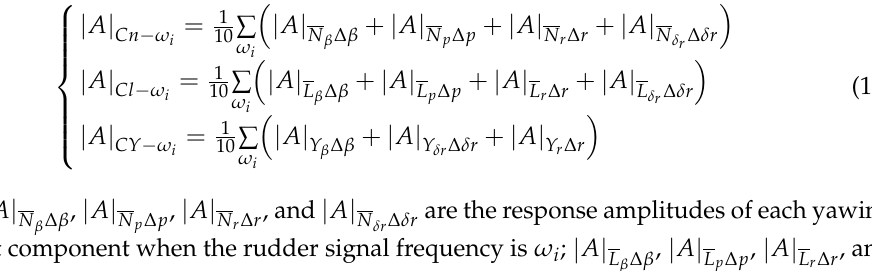
Figure 10. The time domain response of each yawing moment component with different rudder frequency inputs. ( a ) ω = 0.5 rad/s; ( b ) ω = 3 rad/s; ( c ) ω = 10 rad/s.